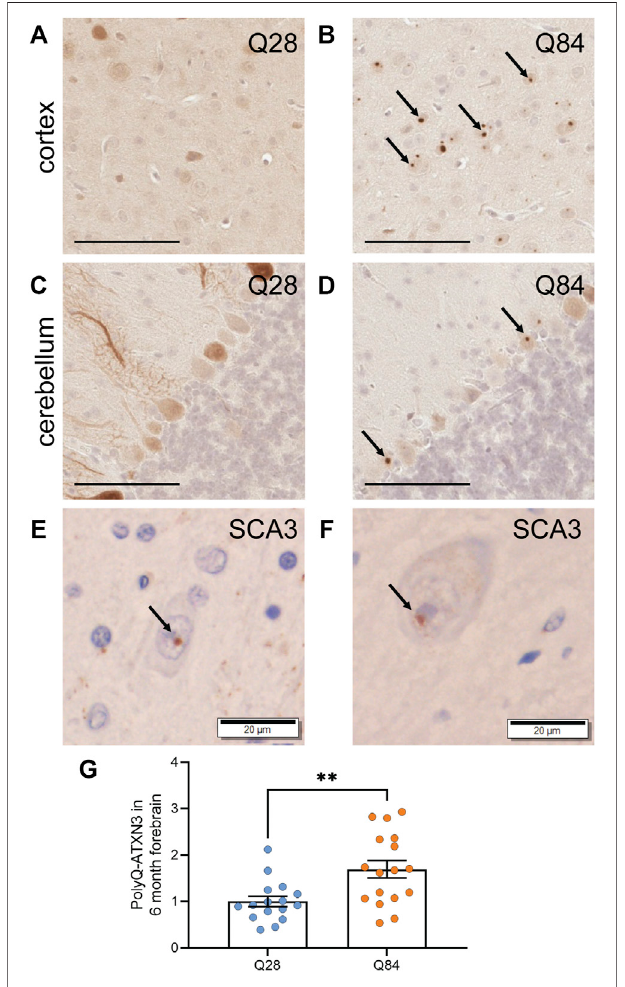
FIGURE 3 | PolyQ-expanded ATXN3 forms inclusions in SCA3 mice (A – D) Representative images of IHC staining for ATXN3 in the cortex (A – B) and cerebellum (C – D) of Q28 (A , C) and Q84 (B , D) mice at 6 months of age. Arrows mark inclusions. Scale bars are 100 µm (E) IHC staining for ubiquitin in the brain of a SCA3 patient. Arrow marks an inclusion. Scale bar is 20 µm. (F) IHC staining for the polyQ antibody clone 1C2 in the brain of a SCA3 patient. Arrow marks an inclusion. Scale bar is 20 µm. (G) PolyQ- ATXN3 levels as measured by immunoassay in the forebrain of Q28 and Q84 mice at 6 months of age. Similar results were seen at 3 months; see Supplementary Figure S5 . Error bars are the SEM. ** p ≤ 0.01 (unpaired t test).